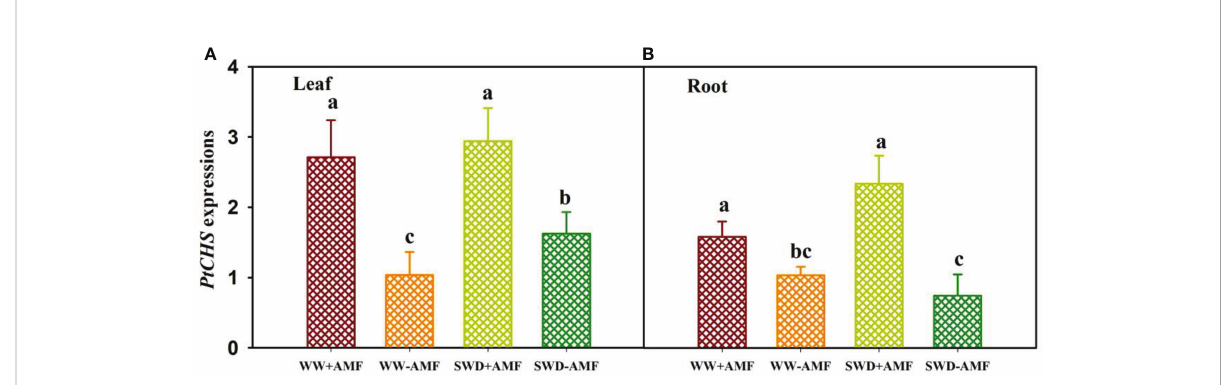
FIGURE 6 PtCHS gene expressions in leaf (A) and root (B) of trifoliate orange seedlings in response to soil water de fi cit and Funneliformis mosseae inoculation. Data (means ± SD, n = 4) followed by different letters above the bars indicate signi fi cant ( P < 0.05) differences between treatments. See Figure 5 for the abbreviations.